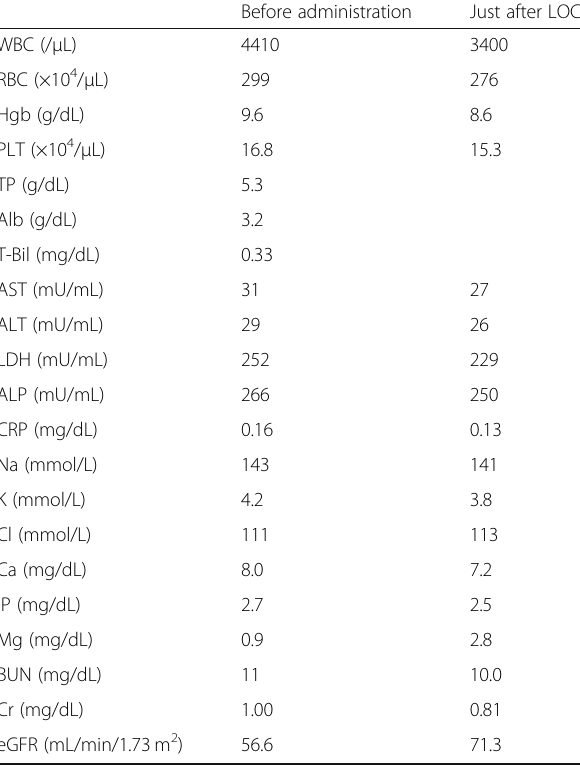
Table 3 Laboratory data before administration of cetuximab and just after loss of